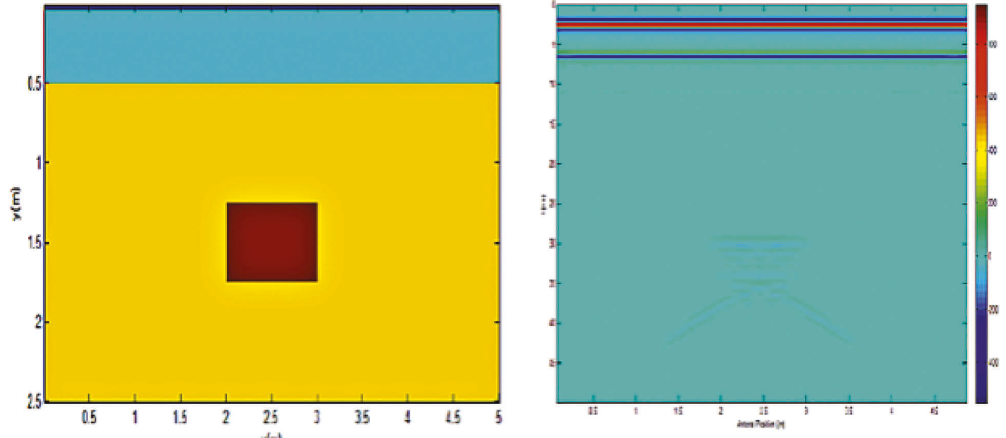
Figure 4: Block leachate pollution model and forward modeling results, left image x(m), right image antenna Position (m).